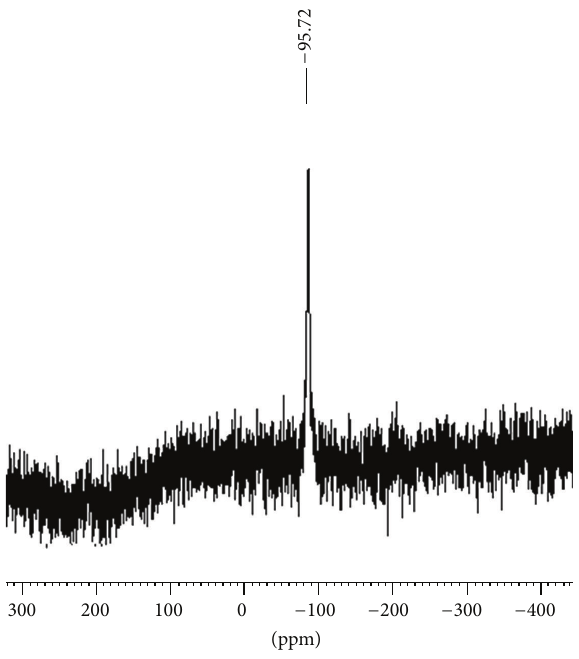
Figure 2: 29 Si NMR spectrum of Me 3 Si(L 2